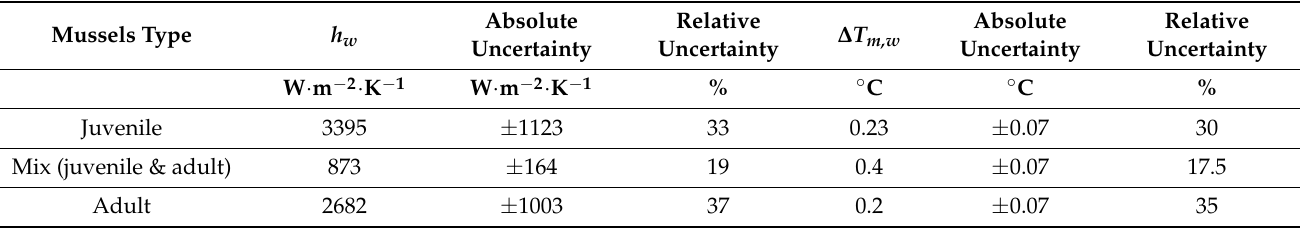
Table 3. Heat transfer coefficient of the water around the mussels as measured experimentally. Absolute Mussels Type h w